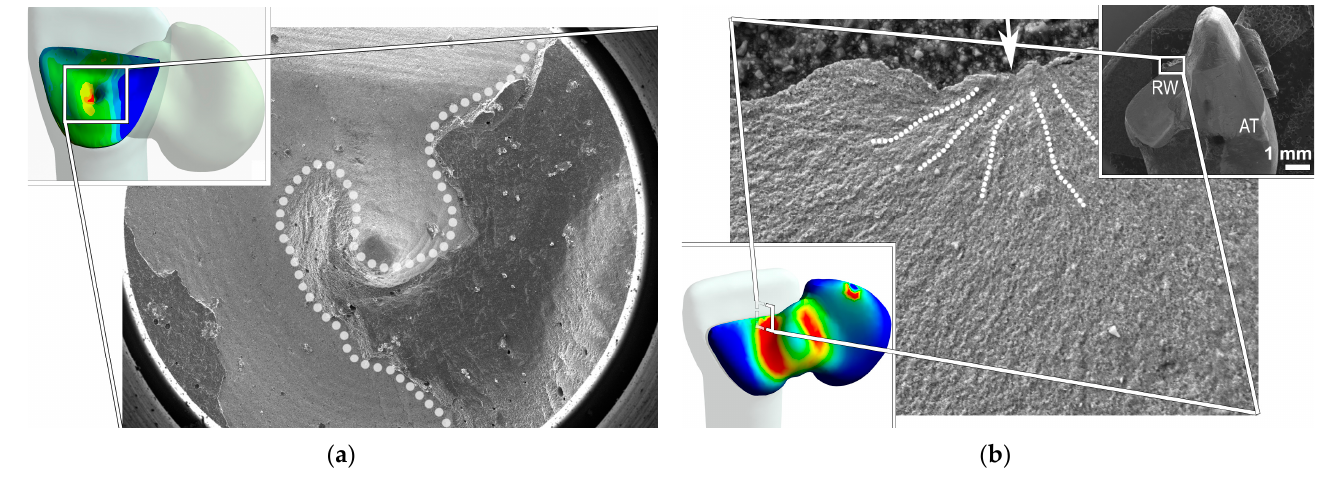
Figure 9. SEM micrographs of fracture patterns relating to calculated stresses. ( a ) Cement fracture pattern (white dotted line) correlating to tensile stress in cement layer (figure inset) (original magnification × 25). ( b ) Retainer wing fracture pattern correlating to tensile stress in RBFDP (left figure inset). At low magnification (right figure inset, original magnification × 8), fractured retainer wing (RW) adhered to the abutment tooth (AT) is observed. A higher magnification (original magnification × 1000) reveals hackles (white dotted lines) pointing to the crack origin in the incisal part of the retainer wing (white arrow). RBFDP, resin-bonded fixed dental prosthesis.